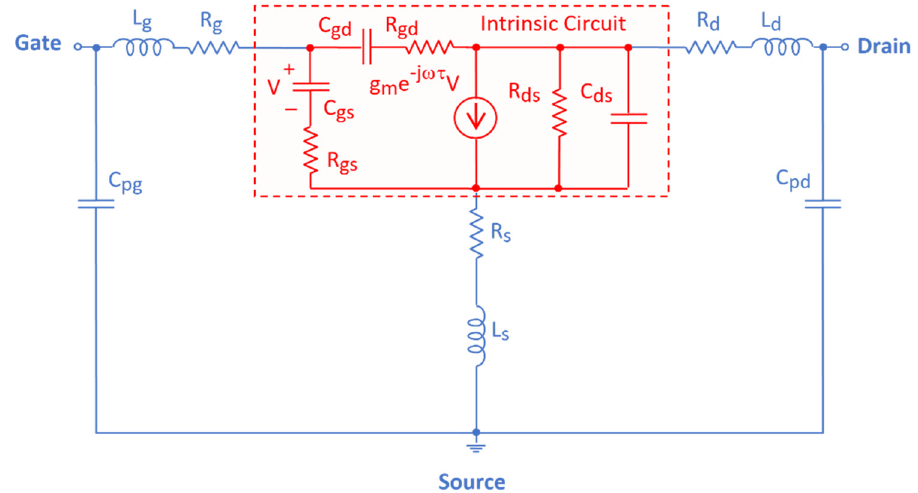
Figure 2. Topology of the small-signal equivalent-circuit model for the tested GaN HEMT.